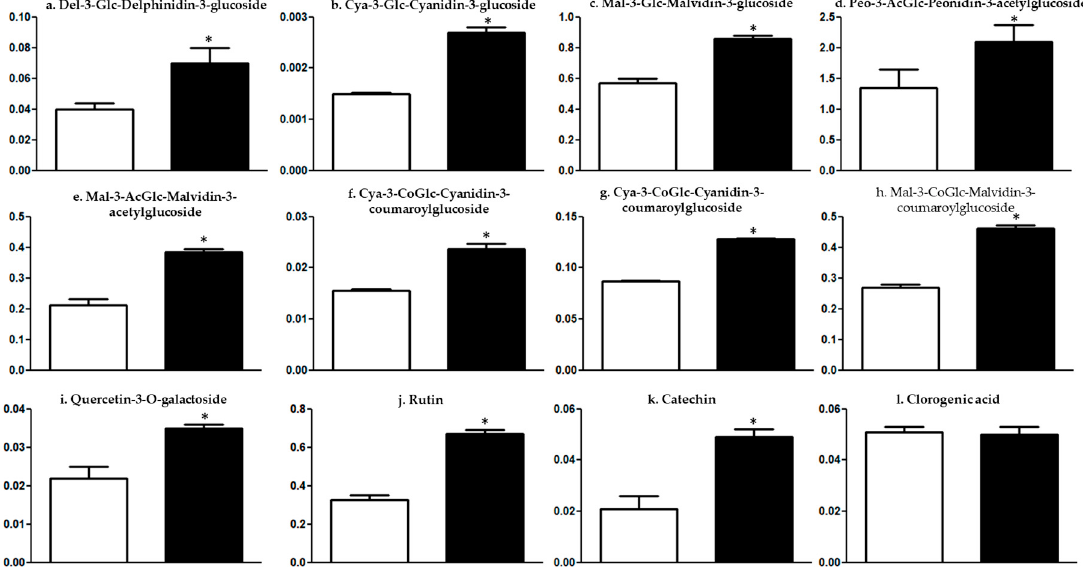
Figure 1. E ff ect of chitosan application at veraison cessation stage on di ff erent monomeric anthocyanins ( µ g / 100 mg dry wt.) and other phenolic compounds ( µ g / 100 mg dry wt.) in Vitis vinifera L. cv. Tinto C ã o grape berry skins, where white column is always control sample and black column is always treatment ( a – l ). Treated samples represent the chitosan applied berry skins (aqueous solution of 0.01% chitosan in 0.01% acetic acid) and control samples represent 0.01% aqueous acetic acid application. Results show mean ± SD from three biological replicates and asterisks represent the significance level as compared to control, by the Students t -test: * p < 0.05.